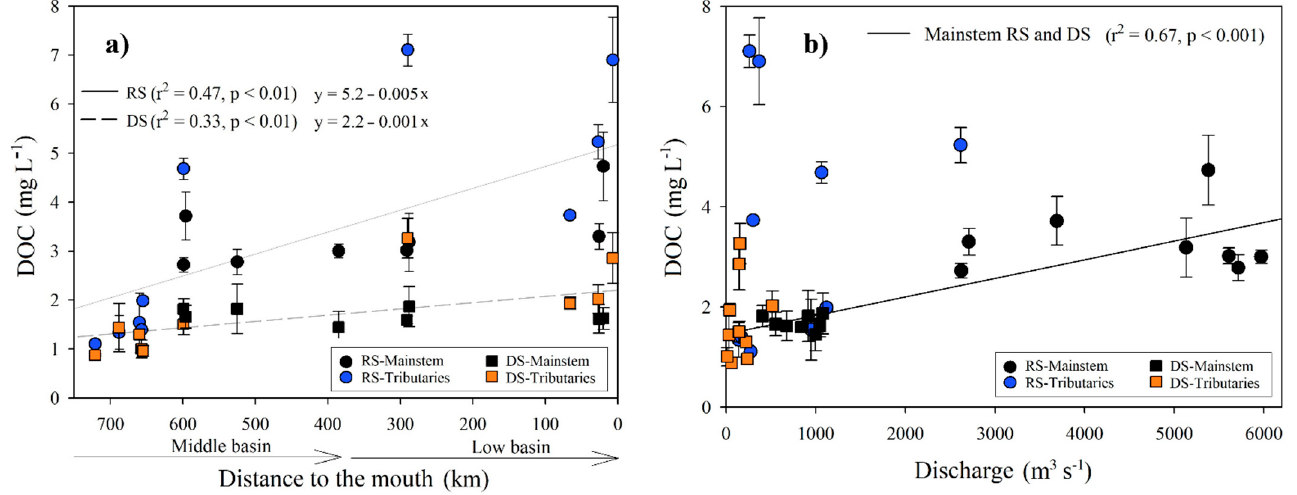
Figure 3. ( a ) Longitudinal variations in the DOC concentration (±SD) according to distance from the Usumacinta River’s mouth during the rainy (RS) and dry (DS) seasons; ( b ) DOC adjustment regarding discharge into the mainstem of the Usumacinta River in the rainy (RS) and dry (DS) seasons. The mainstem differs in both seasons from the tributaries.